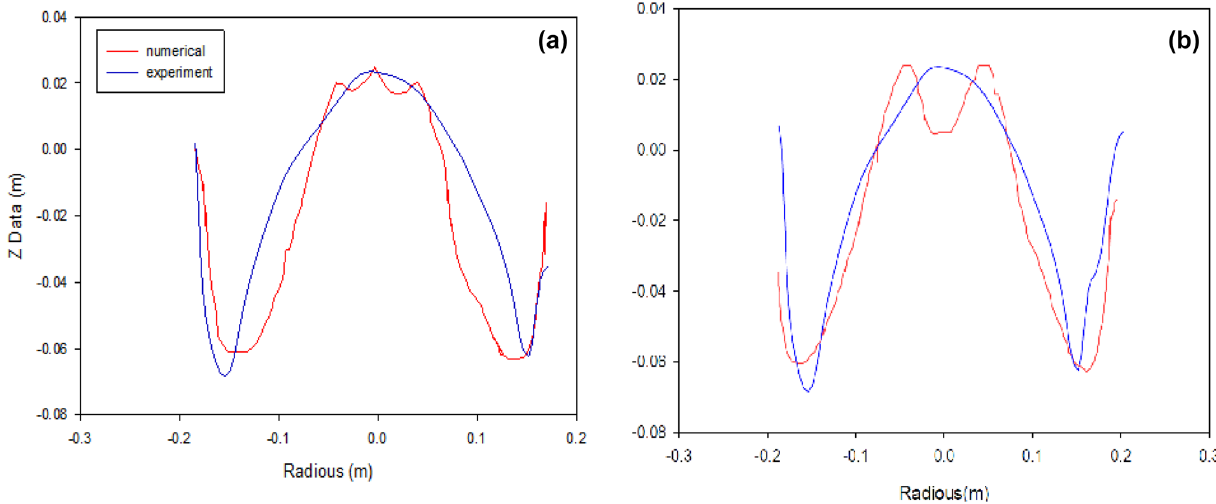
Fig. 23 The comparison between numerical and experimental results of diaphragm deformation at 50% filling volume ( a considering ten- sile force) b not considering tensile